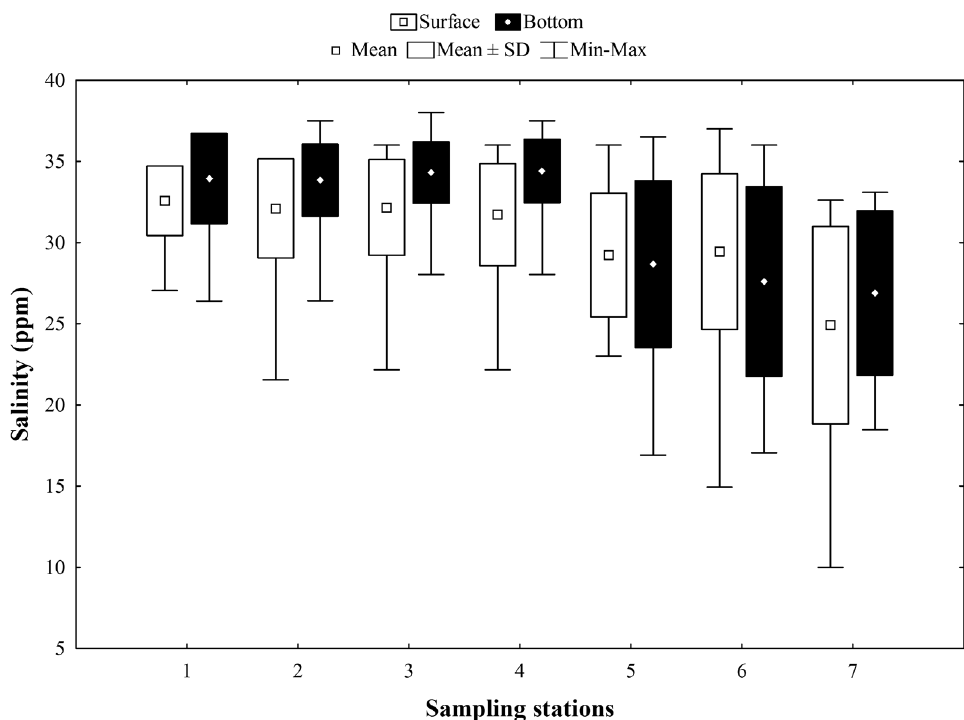
Figure 5. Spatial variation of salinity values of bottom and surface water, from July/2012 to June/2014, in Cananéia region, Brazil. (Mean; SD = standard deviation; Min = minimum; Max = maximum).